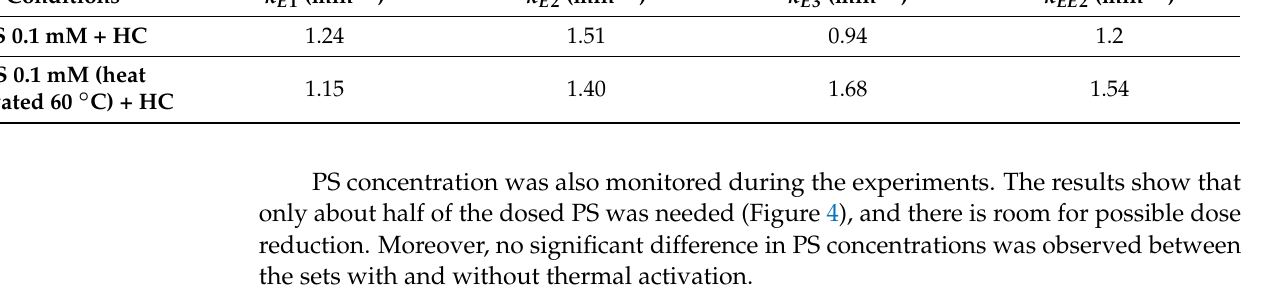
Table 2. The pseudo-first-rate constants of estrogens degradation; r > 0.97.